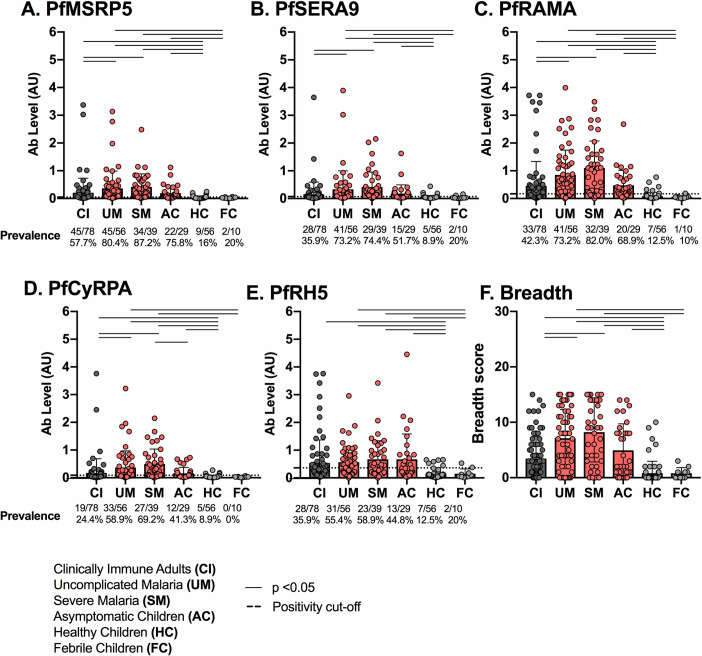
Prevalence and levels of IgM to P. falciparum merozoite antigens per clinical group.Levels (AU, mean with SD) of IgM specific for PfMSRP5 (A.), PfSERA9 (B.), PfRAMA (C.), PfCyRPA (D.) and PfRH5 (E.) were measured in clinically immune adults (CI, dark grey), children with P. falciparum malaria (asymptomatic children (AC), uncomplicated malaria (UM), severe malaria (SM), red) and children without P. falciparum malaria (healthy children (HC), febrile children (FC), light grey). A Kruskal-Wallace test and Dunn’s post-hoc test were performed between all possible combinations of two clinical groups. Combinations with statistical significance only (p < 0.05) are represented by horizontal black lines. All p values regardless of statistical significance are shown in S1 Table in S1 File. Positivity cut-offs are represented by a dashed black line. For each clinical group, the number of positive individuals, total number of individuals tested and percent reactivity is shown at the bottom of each panel.